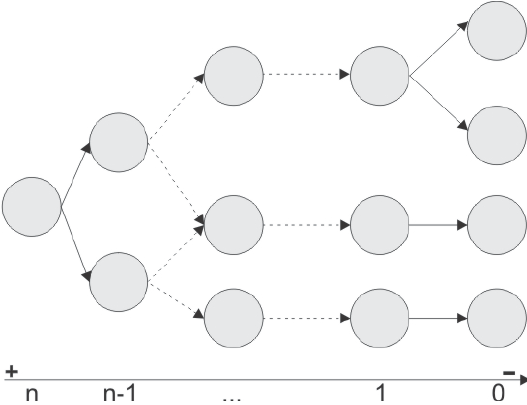
Figure 1. A graphical view reflecting how the degree of complexity of composite operation is